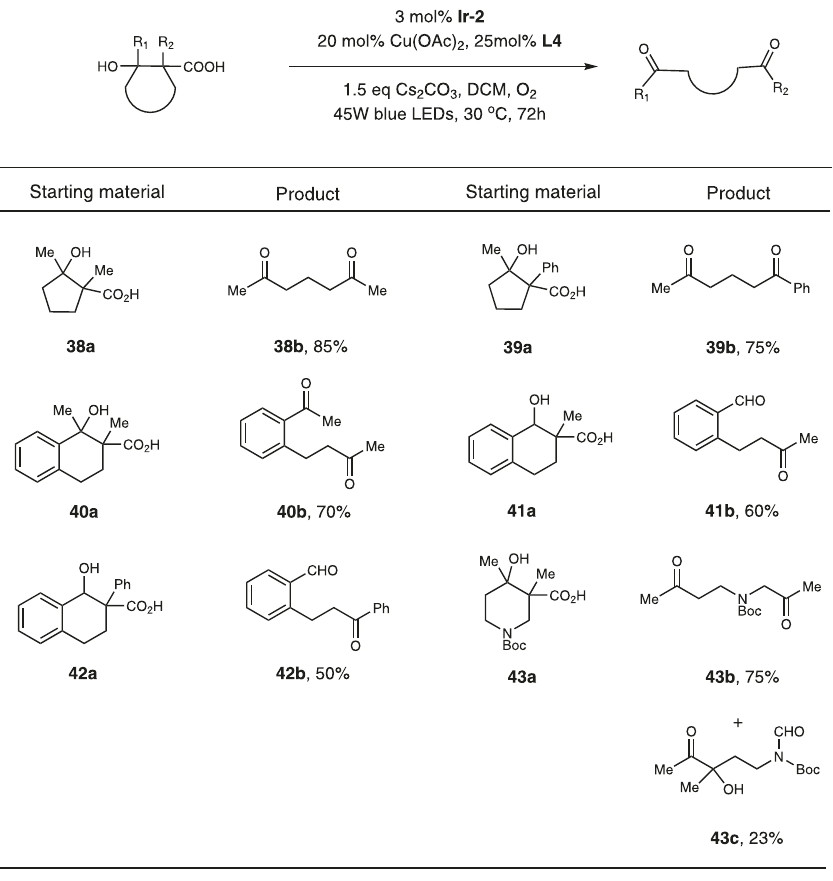
Fig. 5 | Substrate scope of β -hydroxy acids. Reaction conditions: substrate (0.5mmol), Ir-2 (0.015mmol), Cu(OAc) 2 (0.1mmol), L4 (0.125mmol), Cs 2 CO 3 (0.75mmol), DCM (10mL), 45W blue LEDs, 30°C,